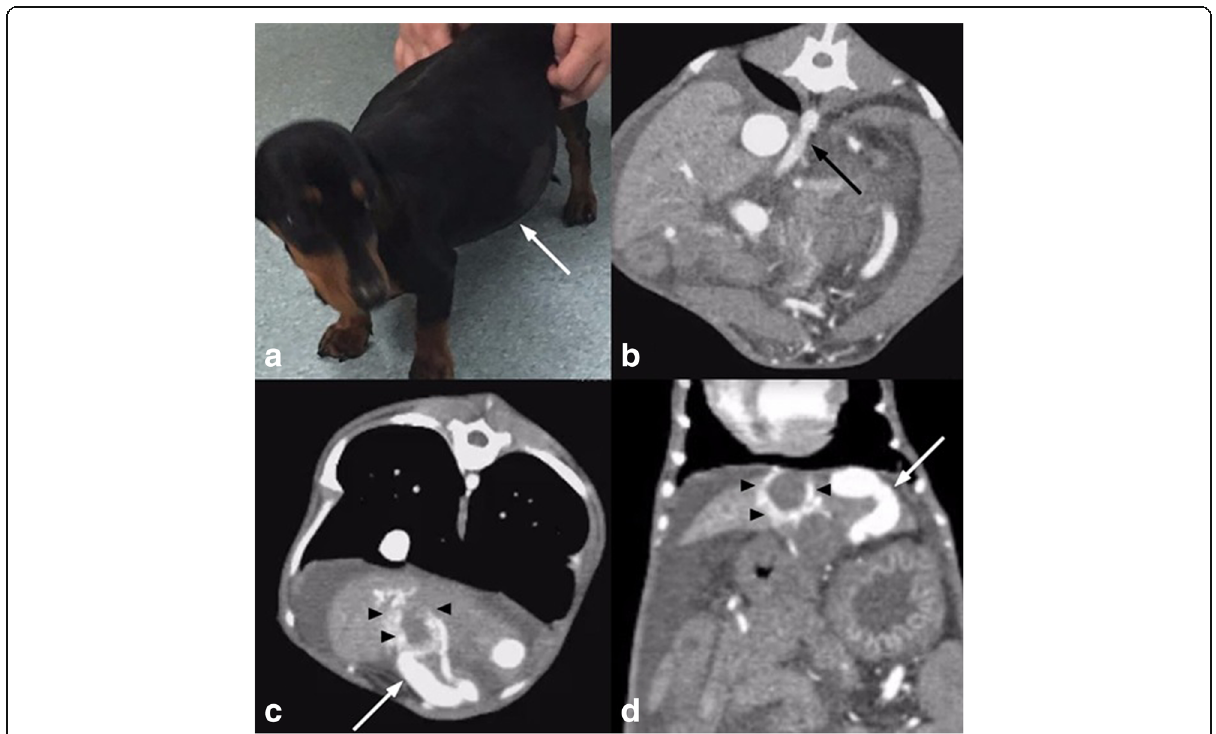
Fig. 1 Patient 1 presenting with a ) tense ascites (arrow) and biochemical hepatic dysfunction. b ) Preoperative CT angiogram demonstrating an enlarged celiac artery (arrow) and extensive ascites. c ) and d ) demonstrate an AVM nidus surrounding the gallbladder fossa (arrow heads) with an enlarged and arterialised draining portal vein branch